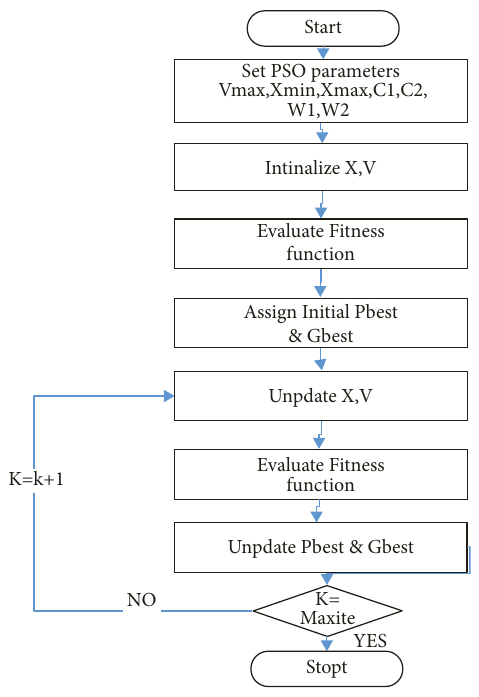
Figure 6: PSO algorithm flow